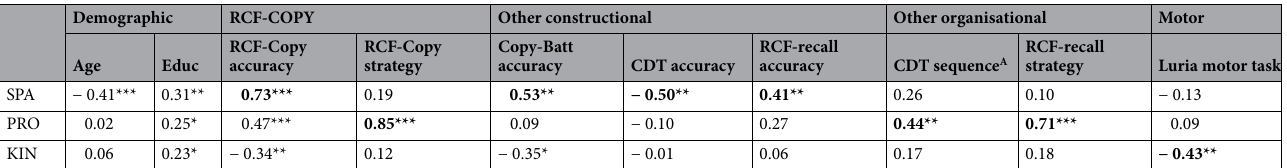
Table 4. Correlation coefficient (r) between T-RCF (i.e., Tablet-based Rey Complex Figure) composite scores (i.e., SPA, PRO, and KIN) with demographic data (i.e., age, education) and conventional scores extracted from the battery of drawing tasks (adjusted for age and education). Highest correlation for each conventional score is shown in bold. Correlations with age, education, and RCF-copy scores, N = 97; correlations with other and 1 for quadrant strategy. RCF Rey complex figure, CDT clock drawing test, CDT clock drawing test, SPA spatial composite score, PRO procedural composite score, KIN kinematic composite